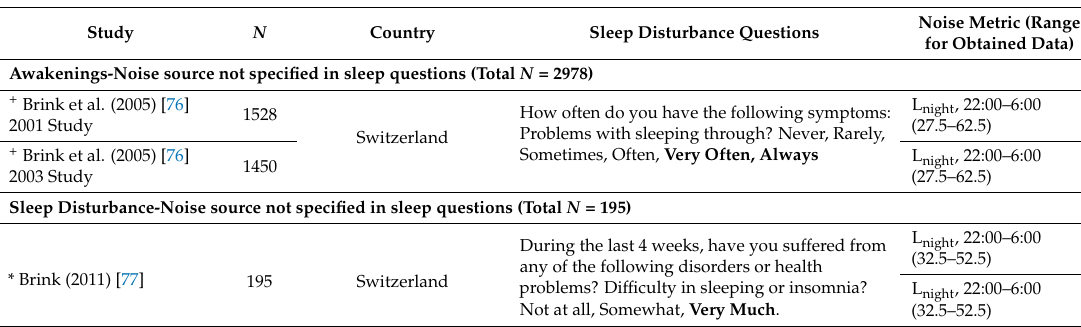
Table 3. Studies on road noise and self-reported sleep disturbance (* general health survey, + noise survey). Studies modeled the noise levels except where indicated. Response alternatives contributing to calculation of the percent Highly Sleep Disturbed are in bold.